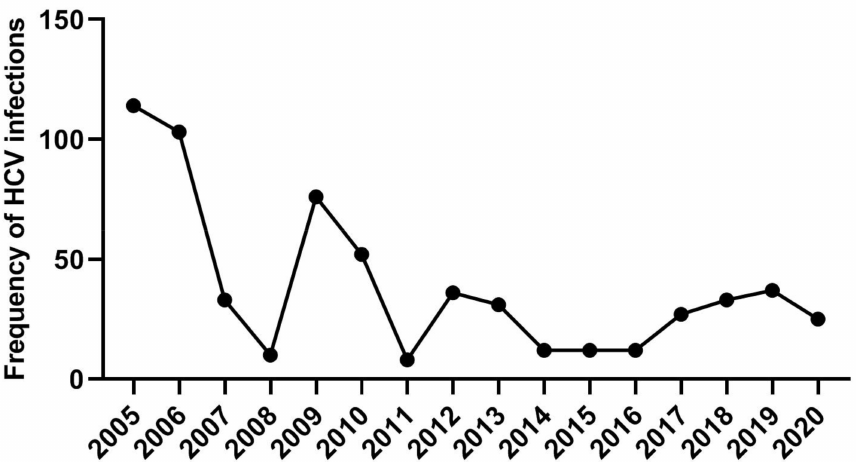
Figure 3. Trend line of anti-HCV positive cases over the study